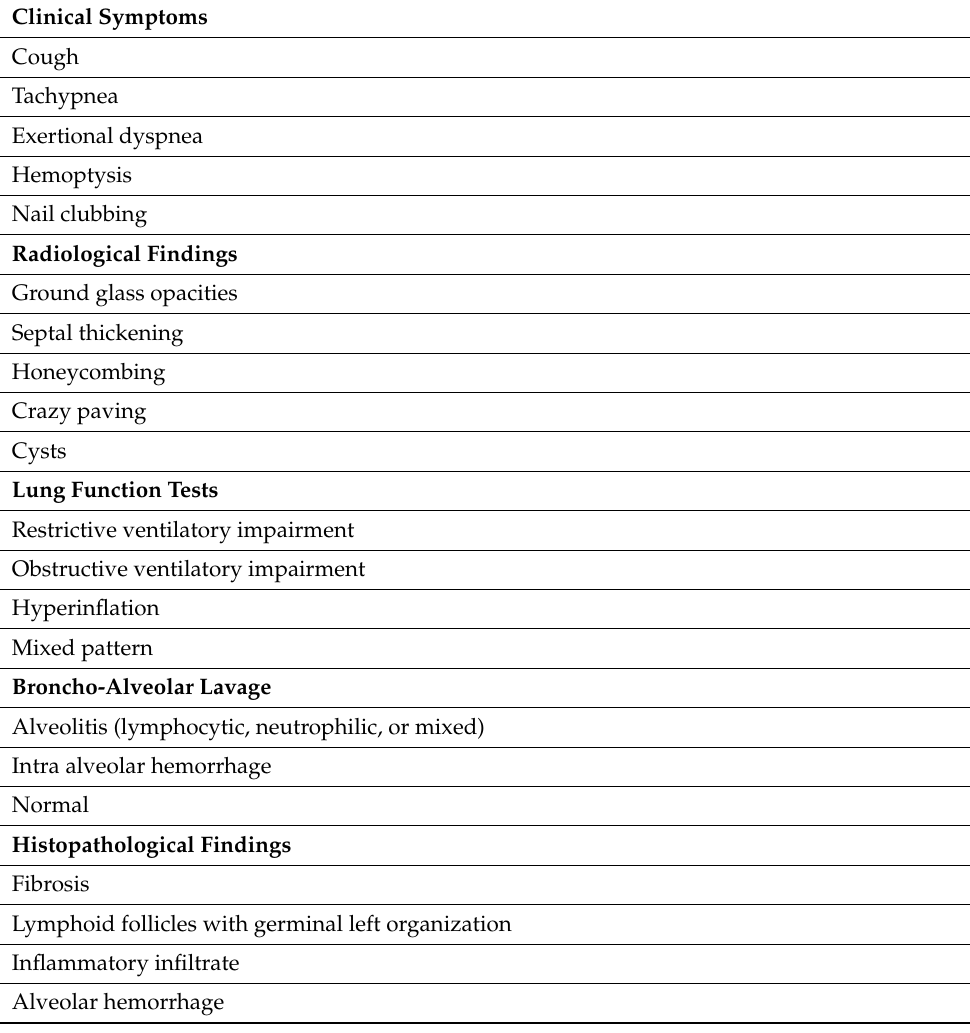
Table 1. Main pulmonary findings in STING-associated vasculopathy with onset in